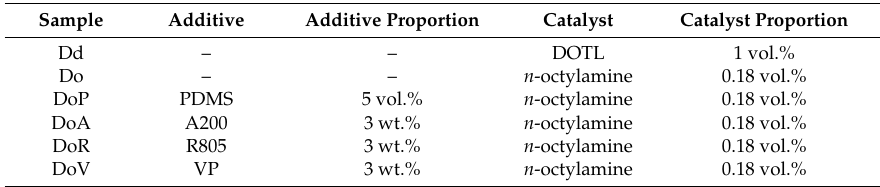
Table 1. Composition of consolidant sols. DYN40 and isopropanol were mixed at 50 vol.%. The concentration of additives and catalysts is related to the volume of DYN40. Sample Additive Additive Proportion Catalyst Catalyst